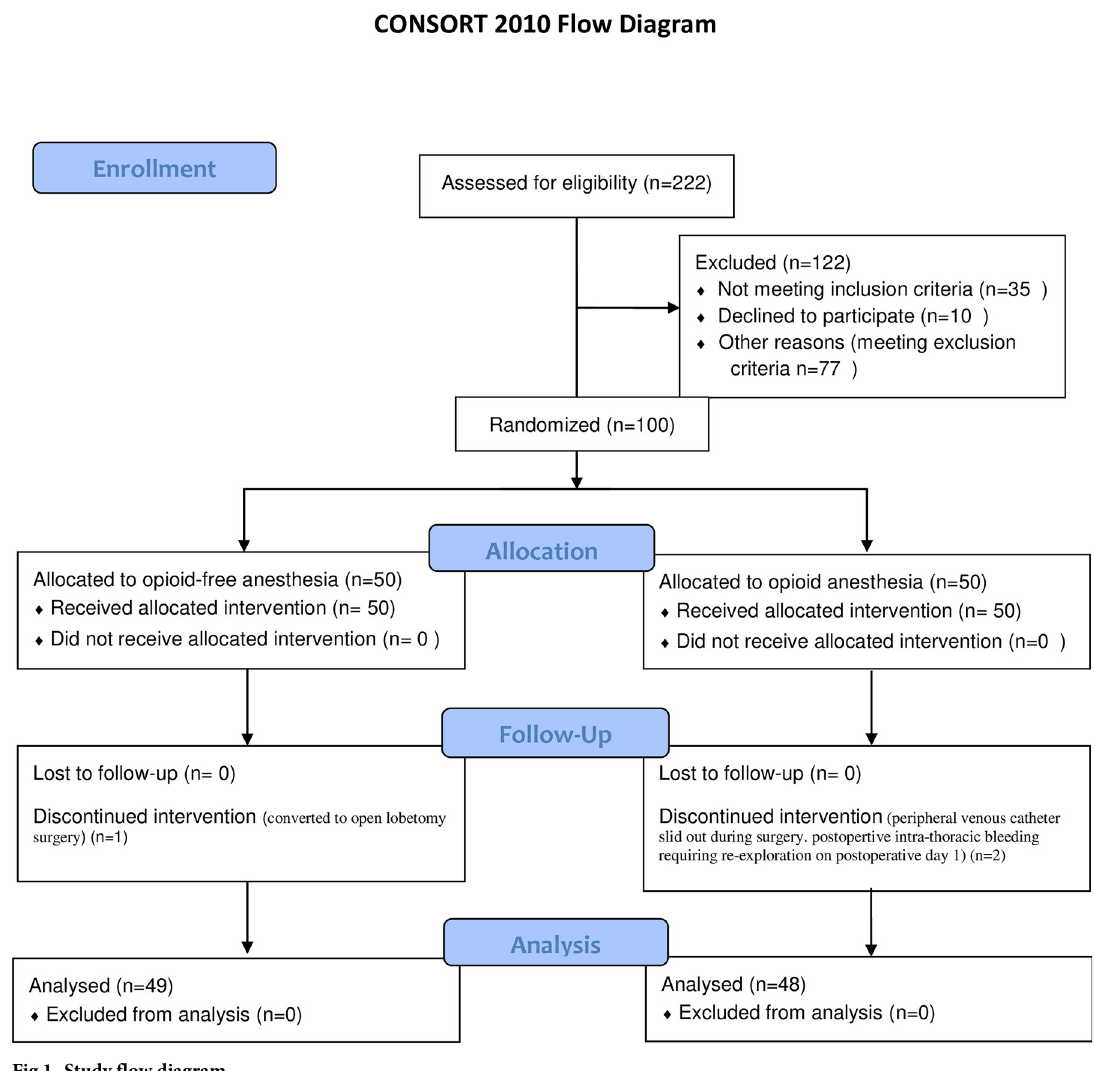
Fig 1. Study flow